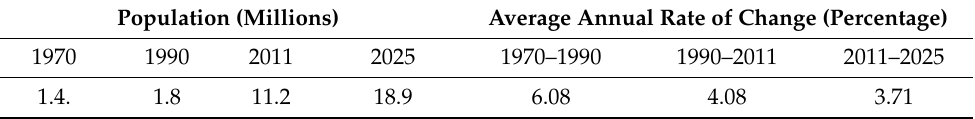
Table 1. Population of Lagos and its average annual rates of change for 1970–2025. Population (Millions)